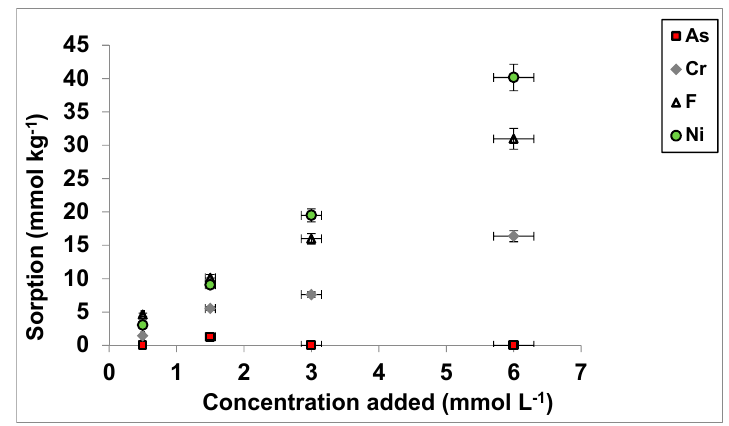
Figure 1. As(V), Cr(VI), F − , and Ni 2+ sorption (mmol · kg − 1 ) for different concentrations added (mmol · L − 1 ) of each element. Average values (with error bars) for 3 replicates, with coefficients of variation always <5%. Table 1. As, Cr, F, and Ni percentage sorption on wheat straw for different concentrations added (C 0